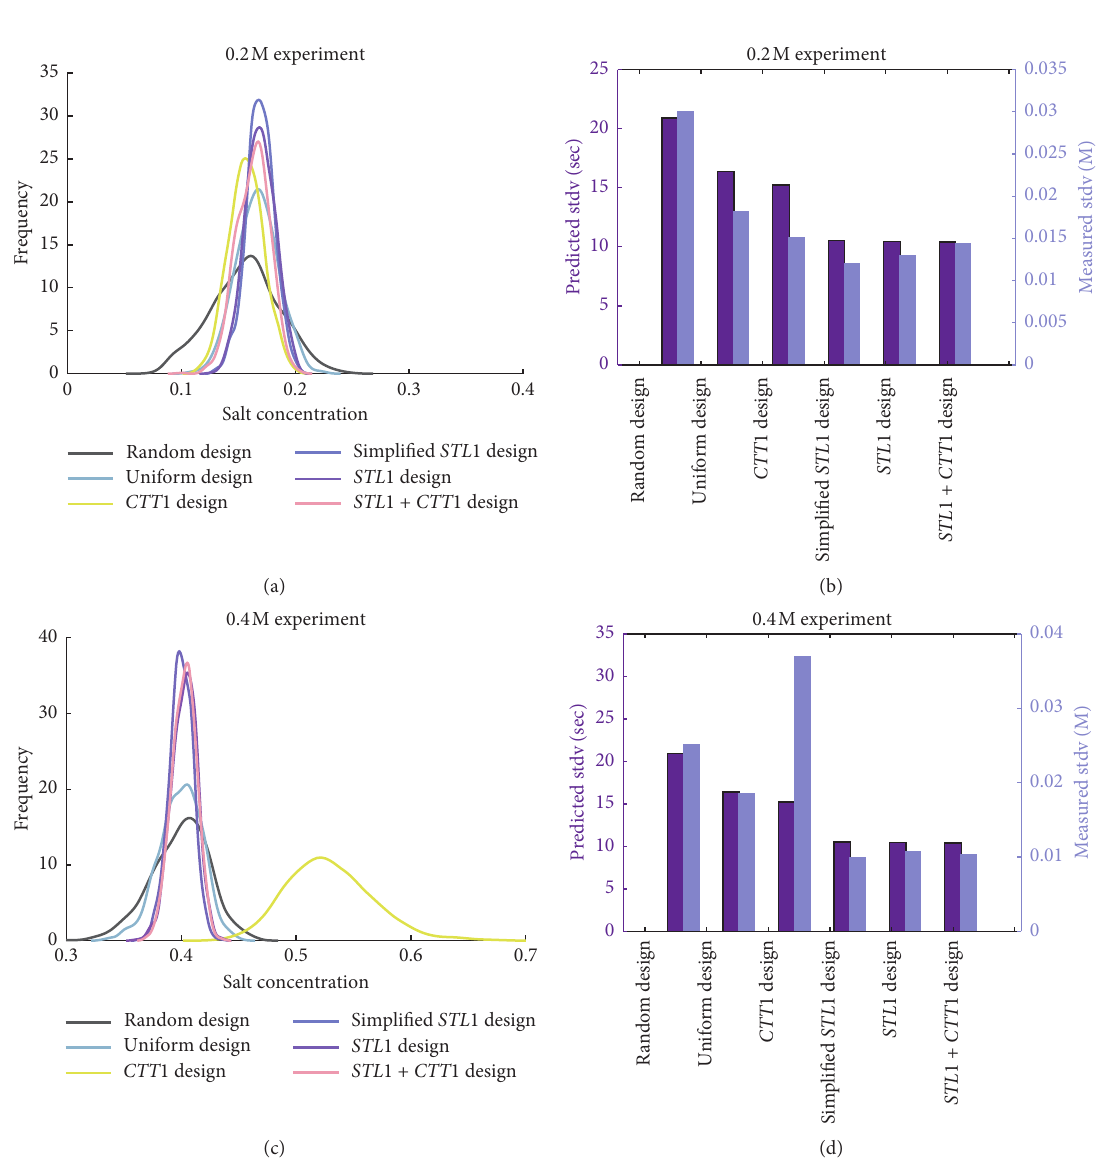
Figure 7: Experimental validation of FSP-FIM-based design for optimal biosensor measurements. (a) Distribution of FSP-based MLE estimates for NaCl concentration using the six experimental designs from Figure 6. Each distribution comes from 1,000 replicas of 75 cells per replica spread out over the possible 16 time points. Replica data were sampled randomly from published experimental data [10] that contain two or three biological replicas and 535–4808 cells per time point. The true experimentally applied level of osmotic shock was 0.2M NaCl. (b) The MLE estimation standard deviation for each experiment design applied to a dataset taken at 0.2 M NaCl (blue). These deviations are compared to FSP-FIM deviation predictions using a piecewise constant model for HOG1 nuclear localization (purple). (c, d) Same as (a, b) but for a true NaCl concentration of